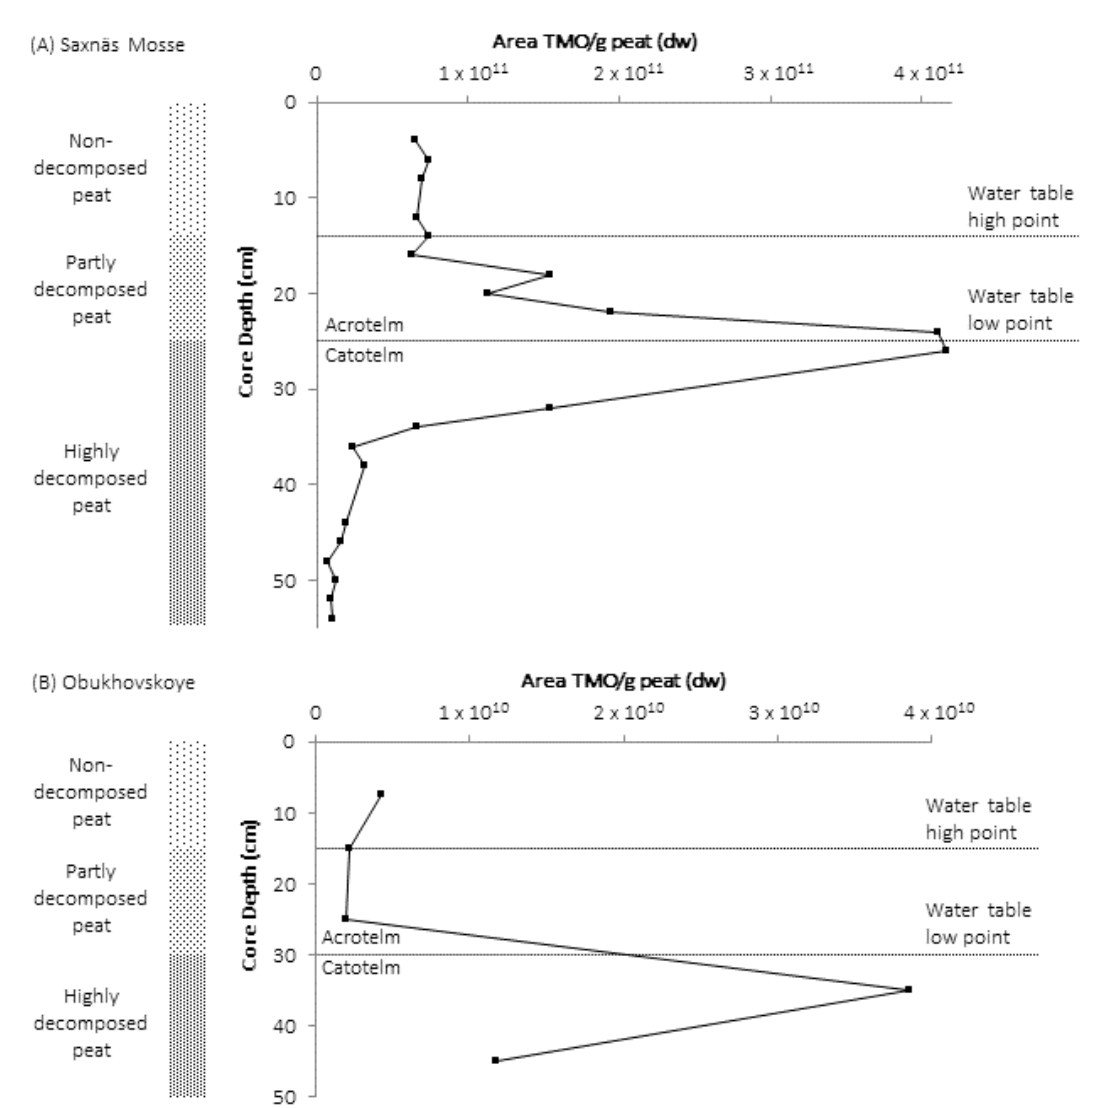
Figure 3. Relative abundances of trimethylornithine IPL (TMO) from HPLC-MS analysis down core in Saxnäs Mosse peat ( A ) and Obukhovskoye peat ( B ). dw, dry weight. Figure adapted from [49].